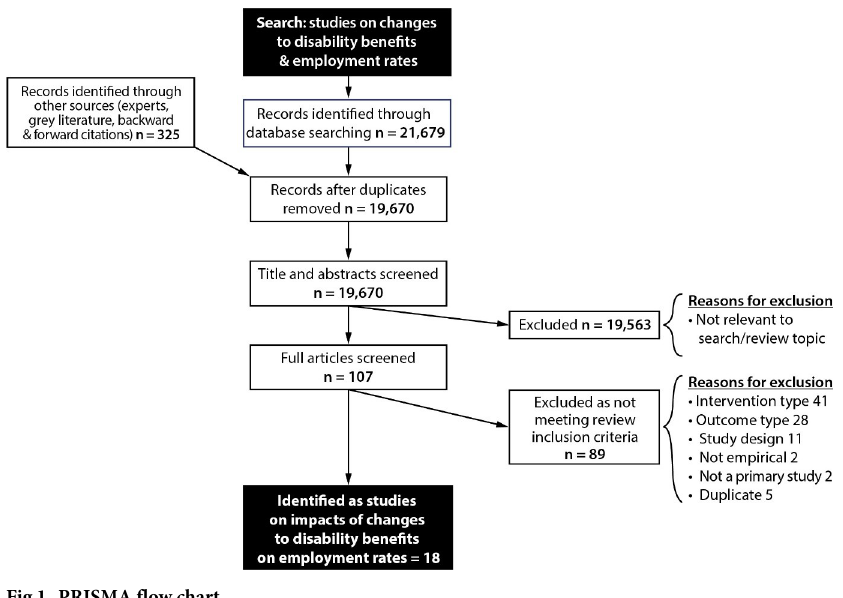
Fig 1. PRISMA flow